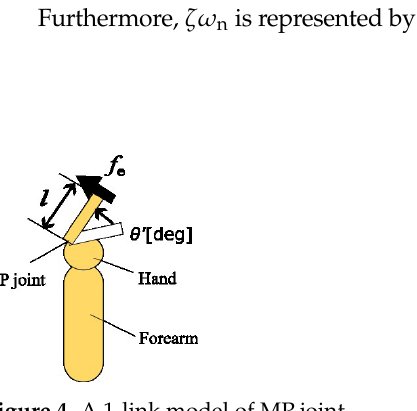
Figure 4. A 1-link model of MP